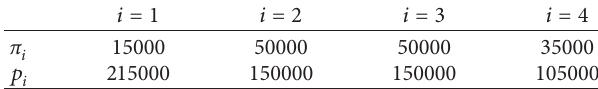
Table 4: Common and uncommon overtime costs.